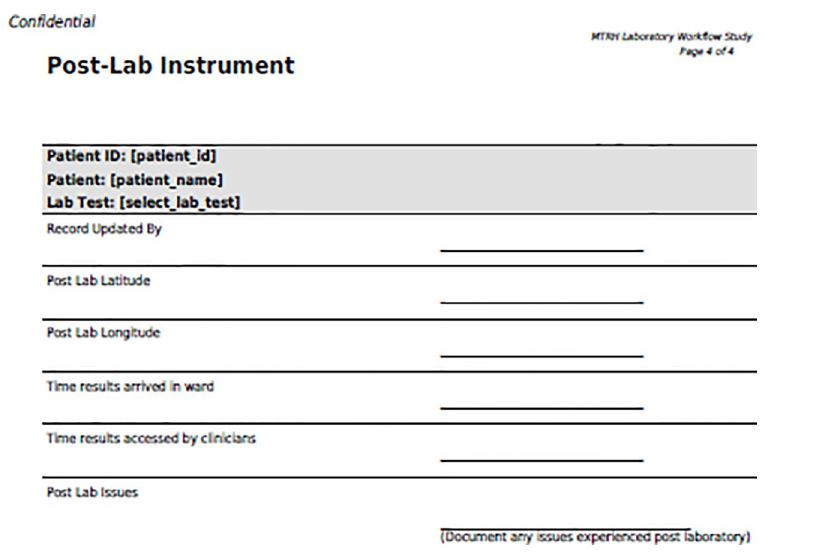
Fig 10. Post laboratory instrument. Instrument used to record data during the post analytical phase.